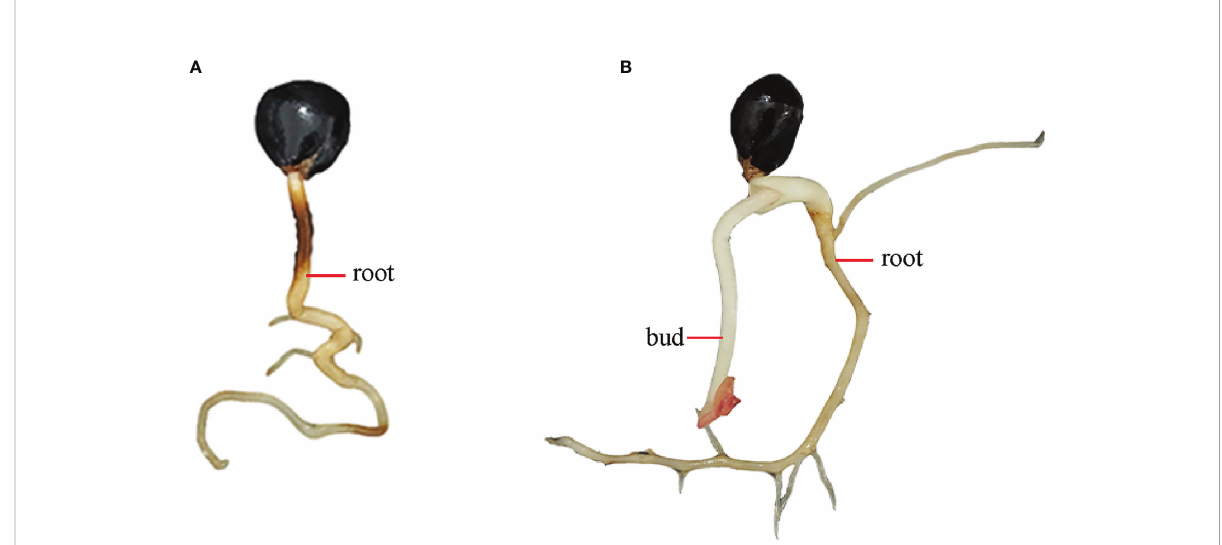
FIGURE 3 Germination states of P. lacti fl ora seed hypocotyls and epicotyls during culture. (A) Hypocotyl germination with the root length of 3-4 cm. (B) Epicotyl germination with the bud length of 2-3